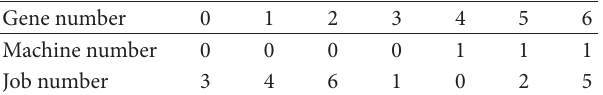
Figure 11: Interaction plot of 𝑃 𝑐 and 𝑃 𝑚 . Table 4: Sample gene structure for an example that contains seven jobs and two machines.